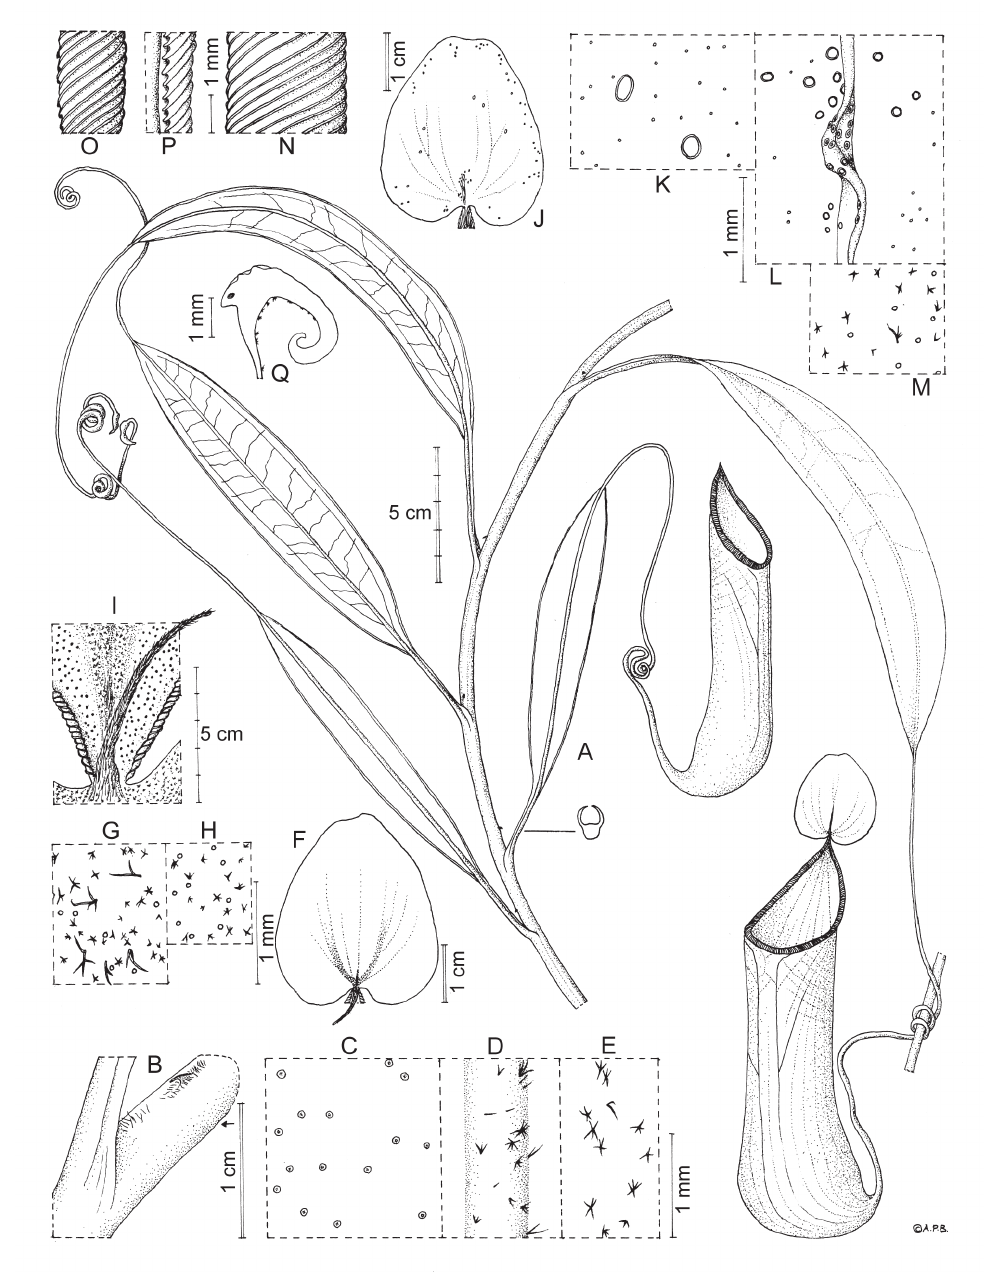
Fig. 4. Nepenthes leyte sp. nov. A . Habit, climbing stem with upper pitchers. B . Stem section showing axillary hair patch and supra-axillary bud. C . Lower surface of leaf-blade, with sessile glands. D . Midrib of leaf-blade, lower surface, stellate to simple hairs. E . Midrib of leaf-blade, upper surface with stellate hairs. F . Upper lid of pitcher, upper surface. G . Indumentum of upper surface of lid, over nerve. H . As G but distant from nerve. I . Spur of upper pitcher and junction of lid with peristome (inverted). J . Lid of upper pitcher, lower surface. K . Detail of J showing large nectar glands. L . Detail of J showing midline ridge with appendage and type (1) nectar glands. M . Indumentum of outer pitcher surface. N . Peristome of upper pitcher viewed from above. O . Peristome viewed from inside pitcher. P . Peristome dissected to expose the inner edge, with teeth. Q . Peristome, transverse section (outer surface on right). All drawn from Argent et al. 99214 by Andrew